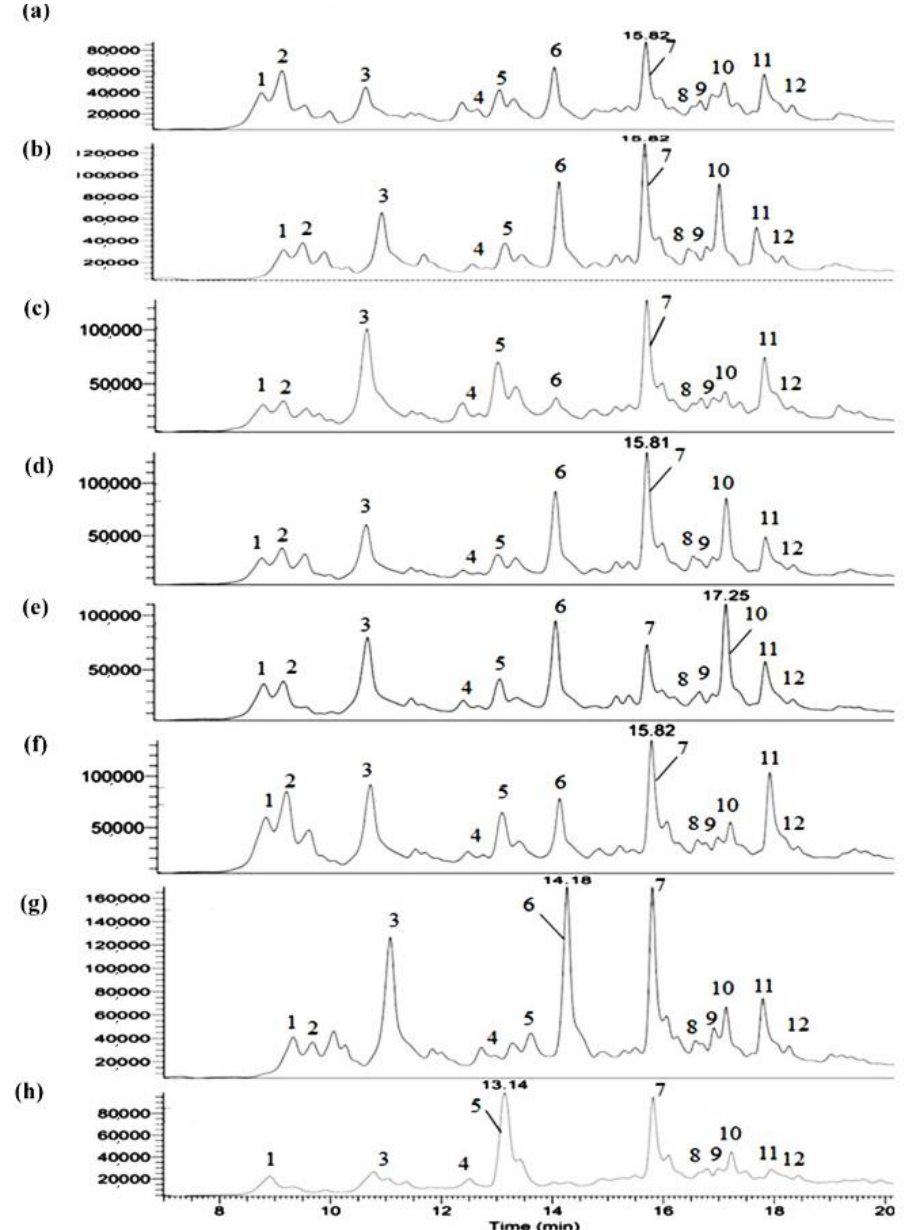
Figure 1. UV282 chromatograms of polar extracts of various varieties of walnut husk ( a ) Aytak; ( b ) Dena; ( c ) Chandler; ( d ) Raha3; ( e ) Raha 4; ( f ) Raha 6; ( g ) green Saman, and ( h ) brown Saman, obtained on the UHPLC-PDA-HRMS/MS system.